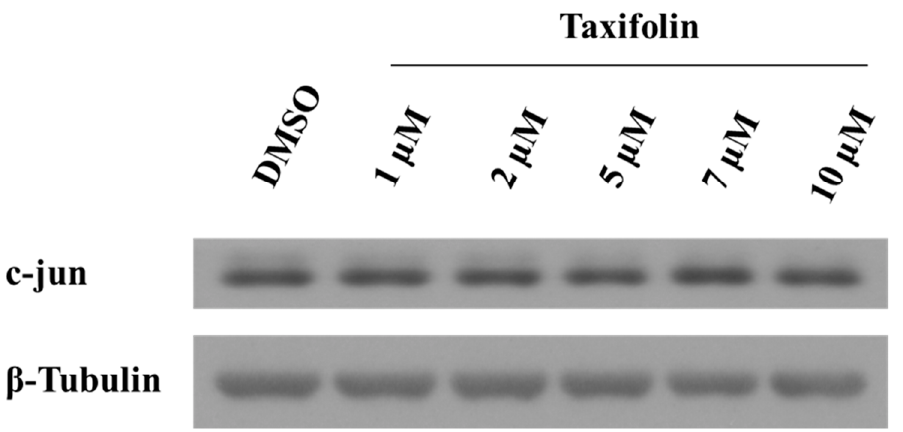
Figure A4. Modulation of c-jun by taxifolin shown as representative Western blot.